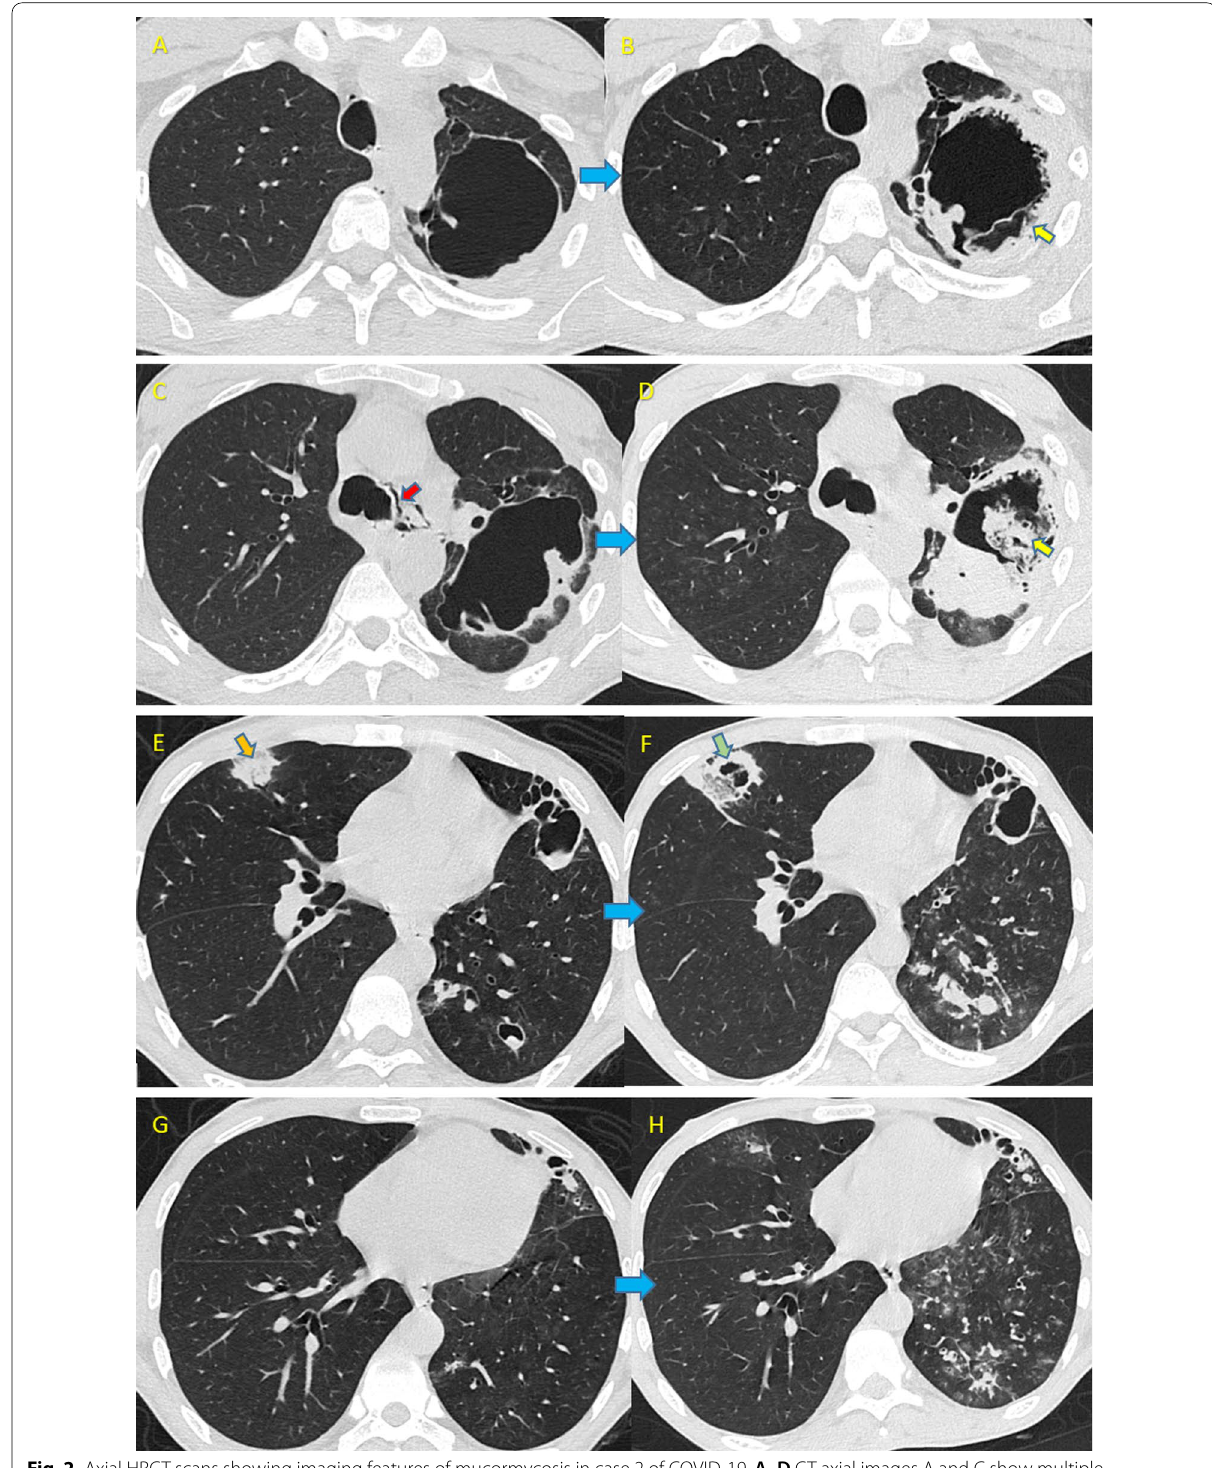
Fig. 2 Axial HRCT scans showing imaging features of mucormycosis in case 2 of COVID-19. A – D CT axial images A and C show multiple cavitary lesions in the left upper and lower lobes. The repeat scans B and D show soft tissue attenuating growth (yellow arrows in B and D ). Mild pneumomediastinum (red arrow in C ) also noted. E , F A new cavity formed in the right upper lobe (green arrow in F ) in pre-existing reverse halo sign (orange arrow in E ). G , H Multiple soft tissue nodular opacities developed especially in left lower lobe in H in comparison with